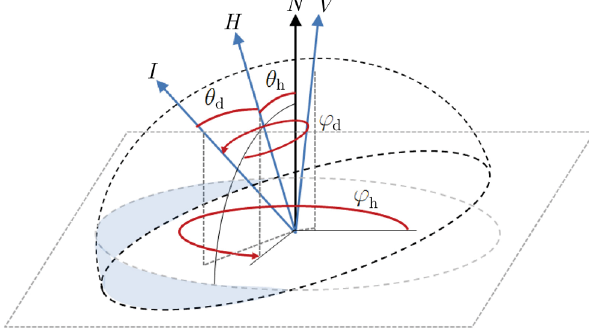
Fig. 1 A half-difference parameterization of incoming I and outgoing V